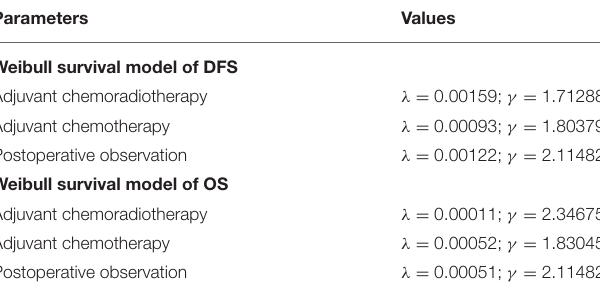
TABLE 1 | Input parameters for the model.